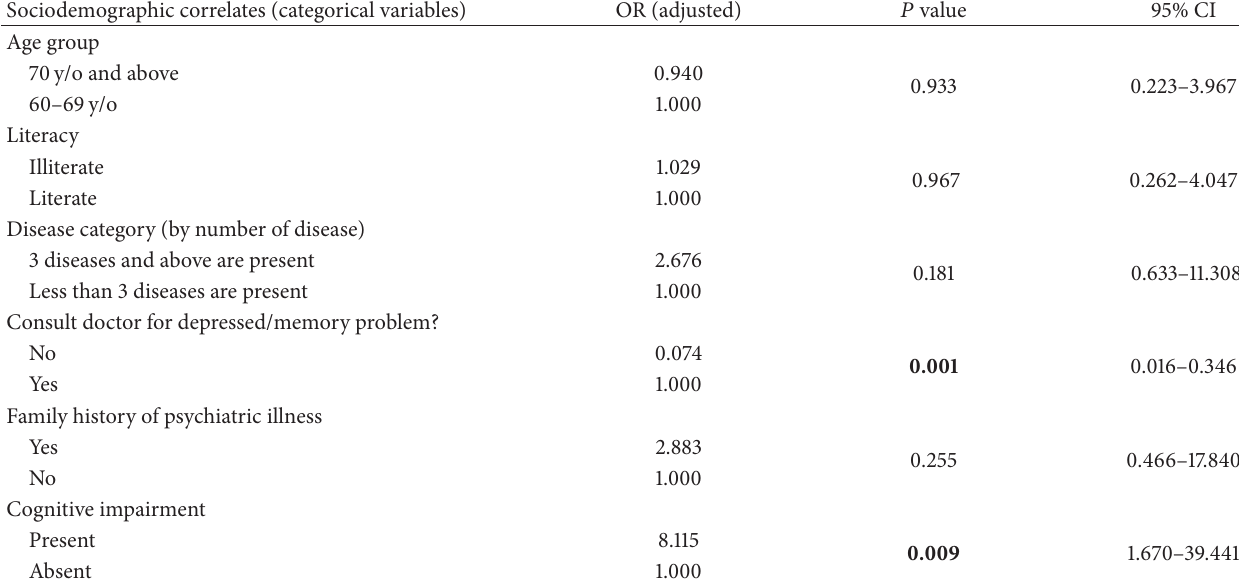
Table 3: Multivariate analysis: sociodemographic correlates of